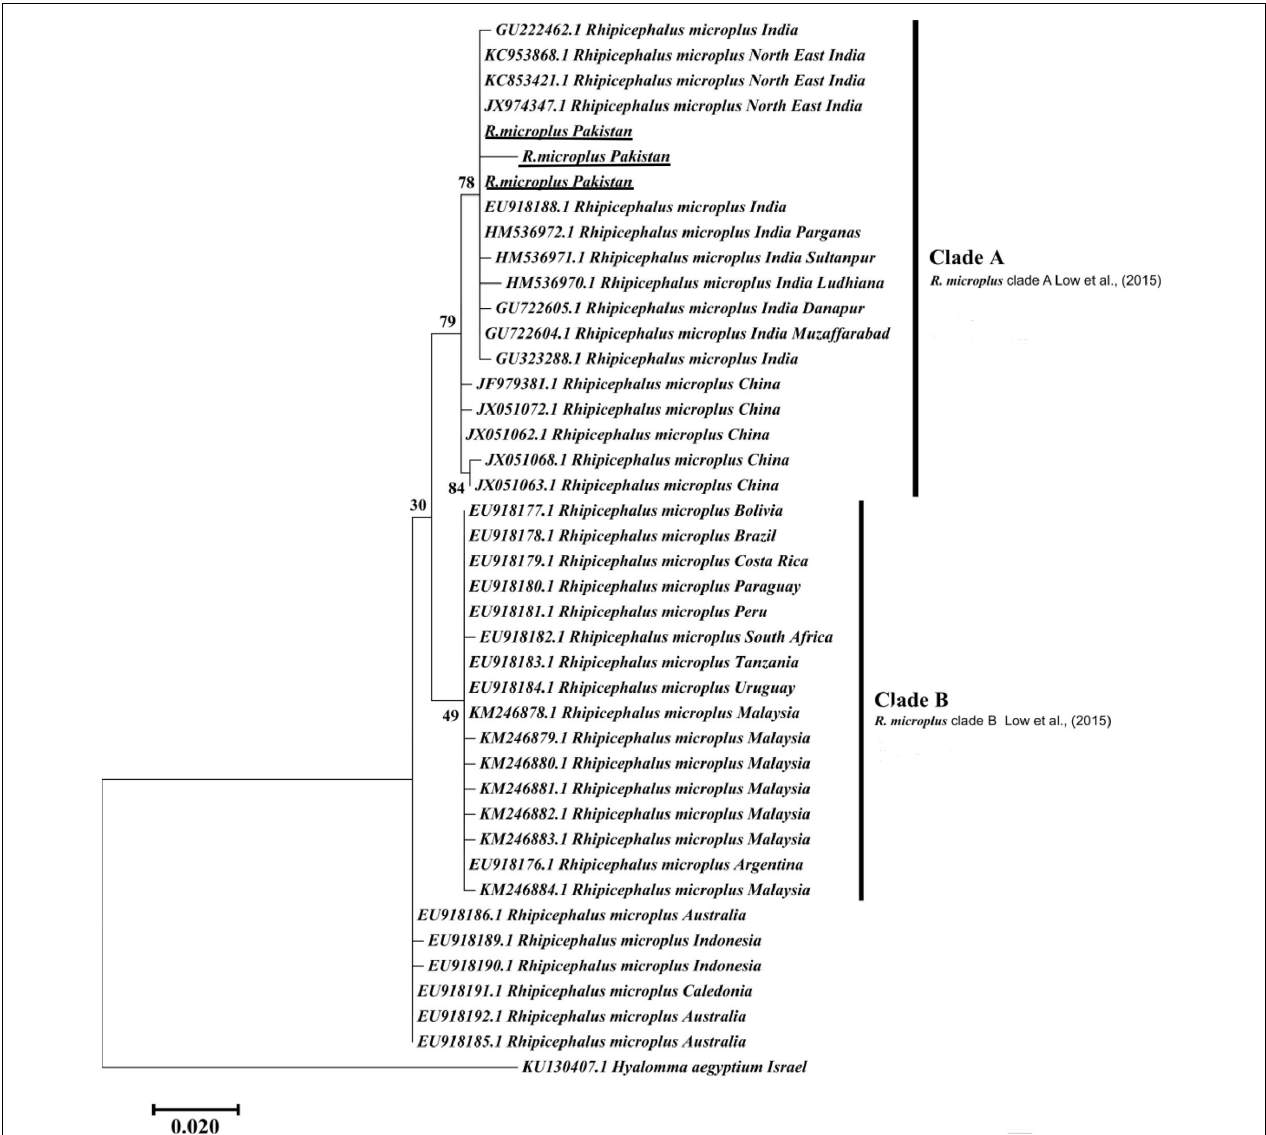
FIGURE 4 | Maximum likelihood tree inferred from 16S rRNA sequences of the genus Rhipicephalus and using Hyalomma sequence as outgrowth. GenBank accession numbers are followed by species name and location of collection. The clade A includes R. microplus from Pakistan, India, and China while Clade B contains R. microplus from Africa, Malaysia and South America. Support values (Bootstrapping values) were indicated at each node. The bar represents 0.020 substitutions per site. Sequences obtained in the present study were